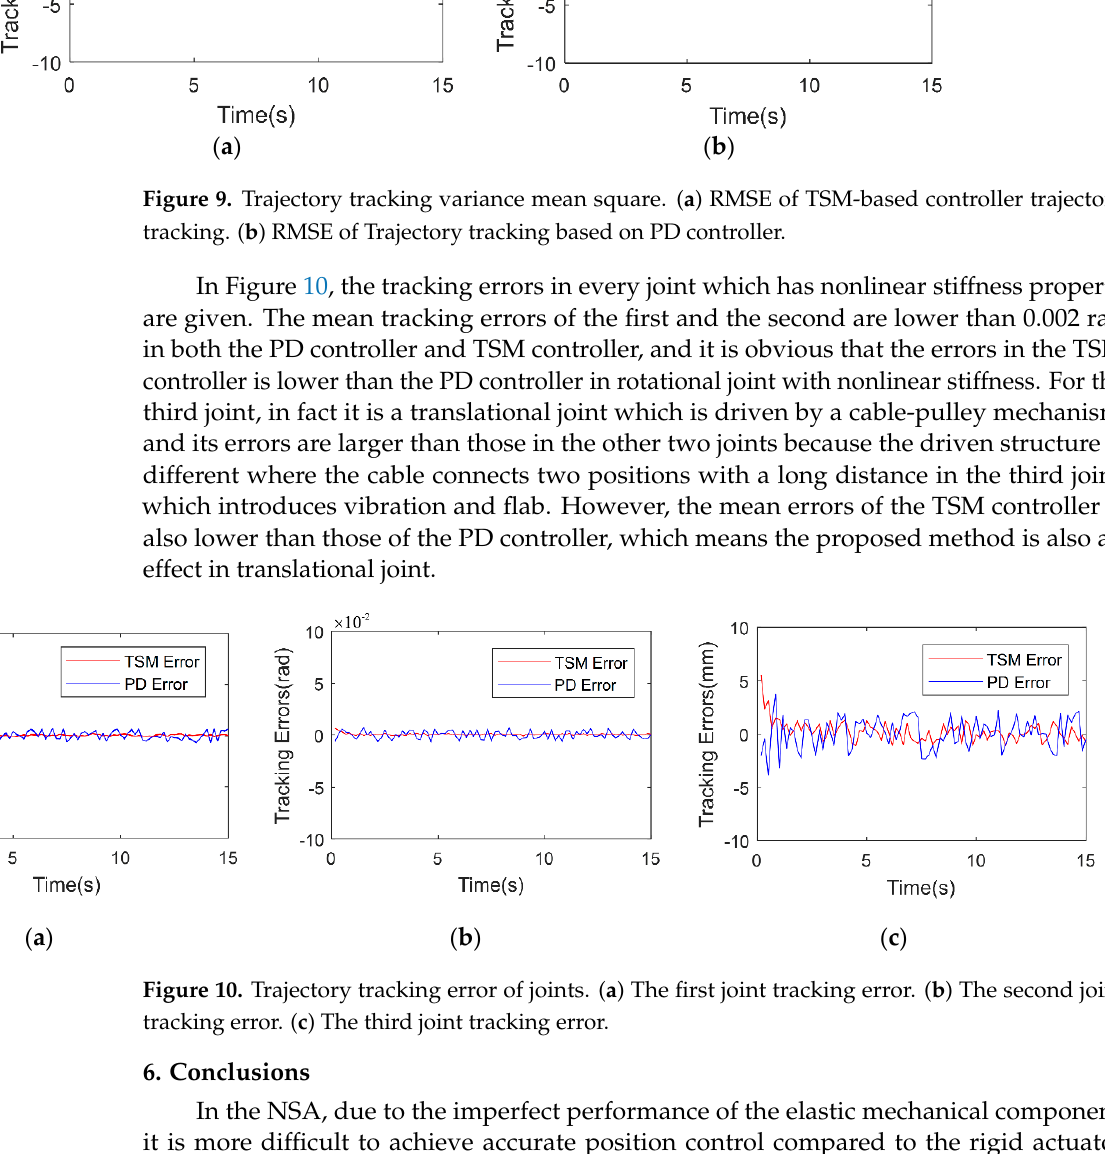
Figure 10. Trajectory tracking error of joints. ( a ) The first joint tracking error. ( b ) The second joint tracking error. ( c ) The third joint tracking error.